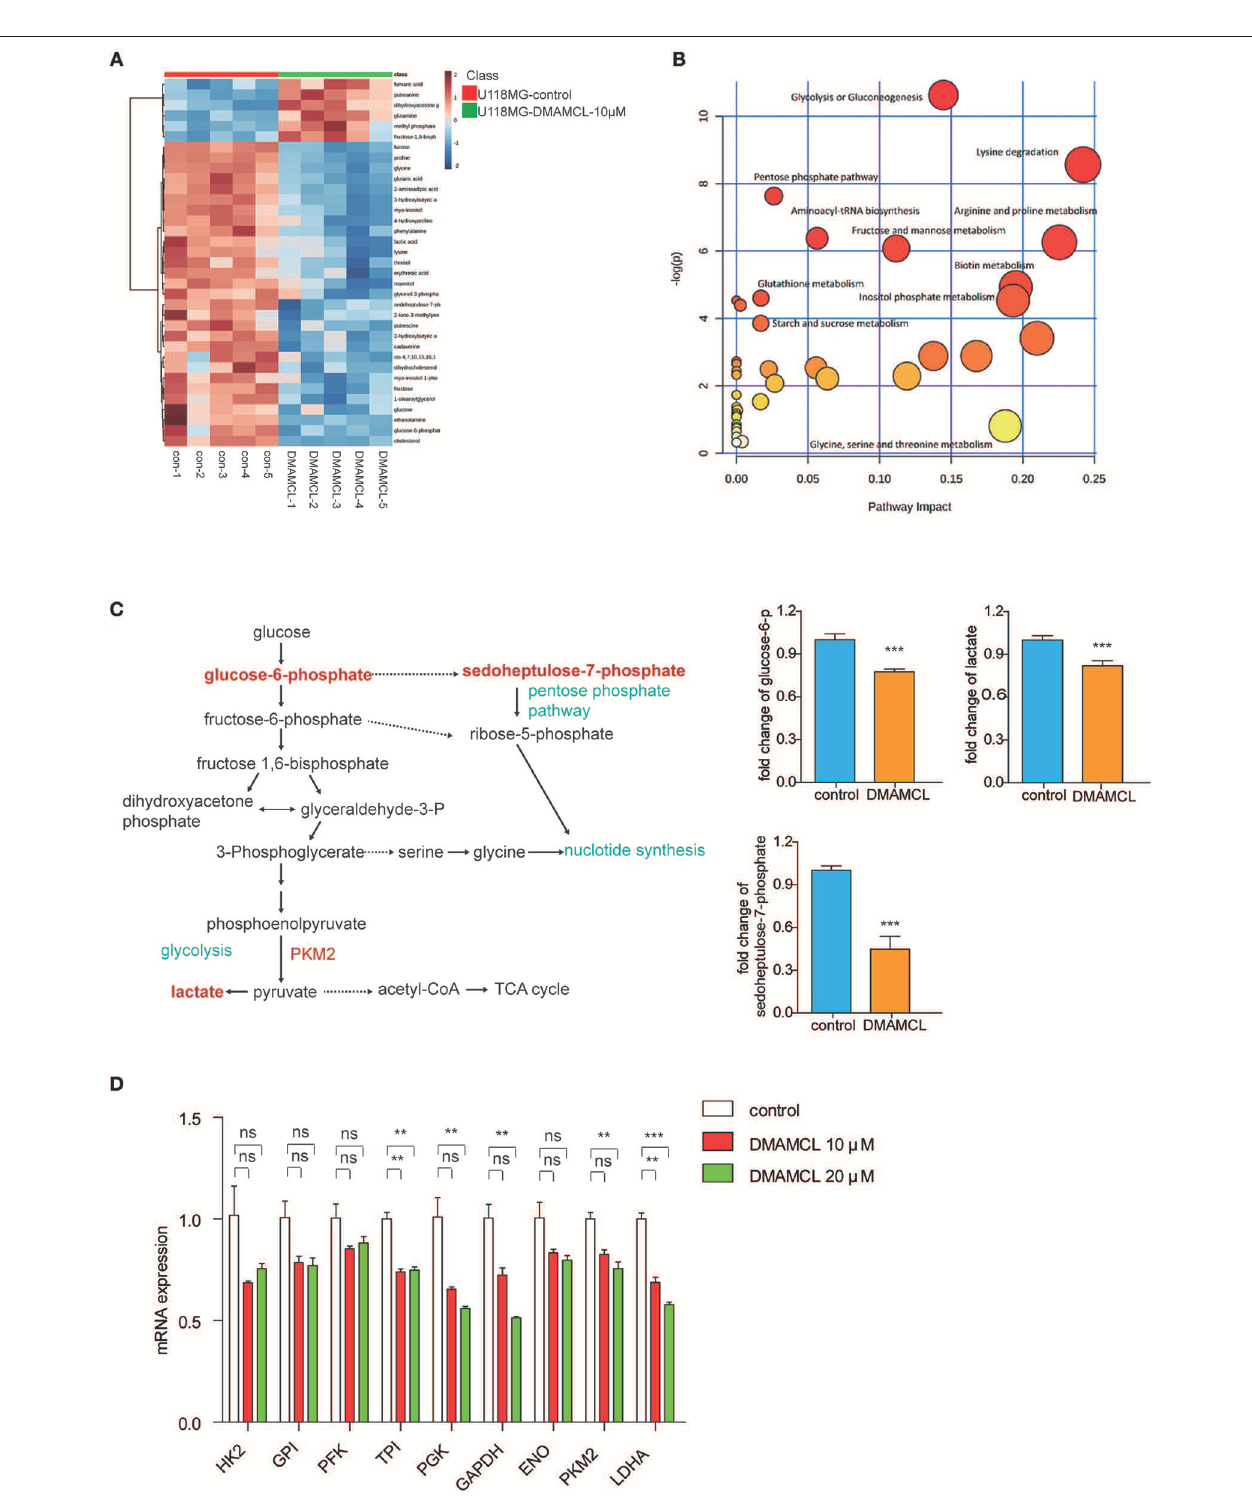
FIGURE 4 | DMAMCL treatment inhibited anaerobic metabolism and anabolism in U118MG cells. (A) Heat maps of identified differential metabolites in U118MG cells treated with DMAMCL-10 µ M ( n = 5). (B) Differentiated metabolic pathway analysis with MetaboAnalyst 2.0 in U118MG cells treated with DMAMCL-10 µ M. (C) The glucose metabolism and the key metabolites (glucose-6-P, lactate, sedoheptulose-7-phosphate levels in U118MG cells treated with DMAMCL). (D) The mRNA expression of metabolic enzymes involved in aerobic glycolysis. Error bars, mean ± s.e.m., n = 3 biological replicates. ** P < 0.01, *** P < 0.001, ns, no significant.